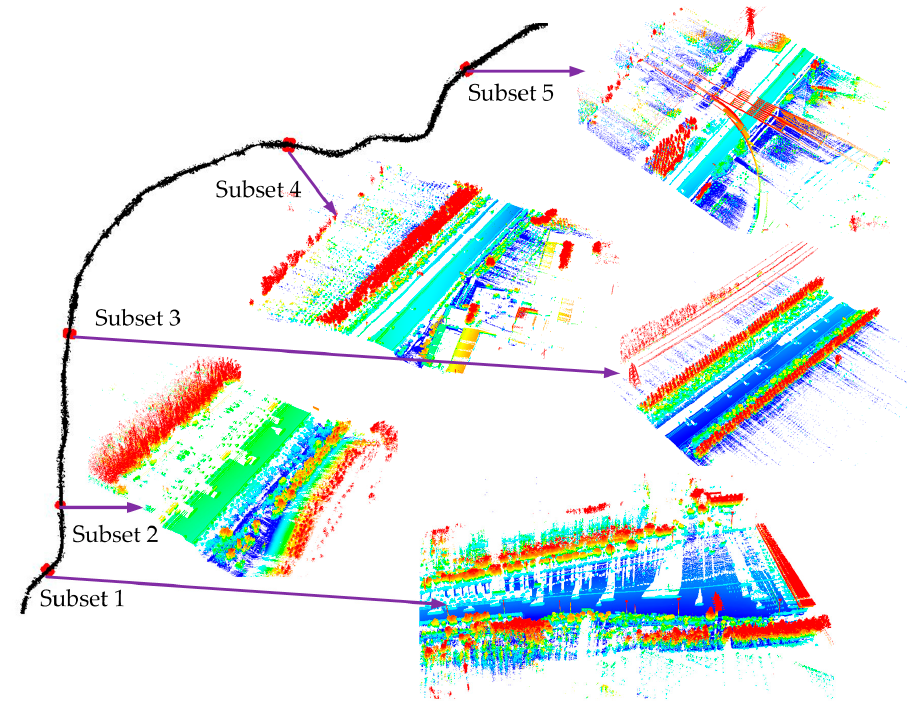
Figure 1. The collected mobile LiDAR (light detection and ranging) scanning (MLS) point clouds and five test subsets. The point clouds of the five subsets are colored by elevation. Different ground surface types and non-ground objects were contained in the selected test data.